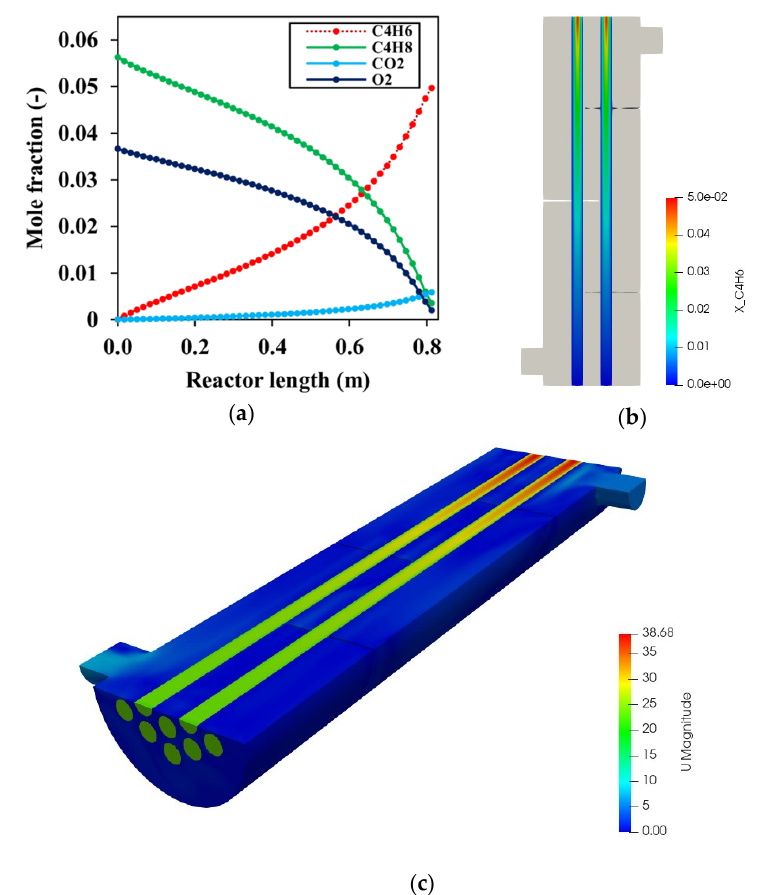
Figure 8. Mole fraction distribution and mole fraction contour plot under non ‐ isothermal conditions: ( a ) mole fraction distributions of each species; ( b ) contour plot of butadiene mole fraction; ( c ) 3D velocity profile.